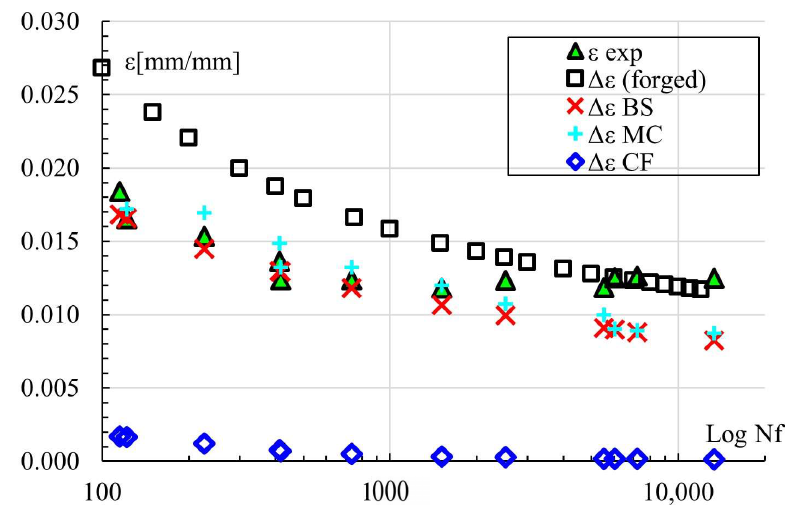
Figure 10. ε vs. N f for the Ti−6Al−4V alloy obtained by EBM and as-forged.